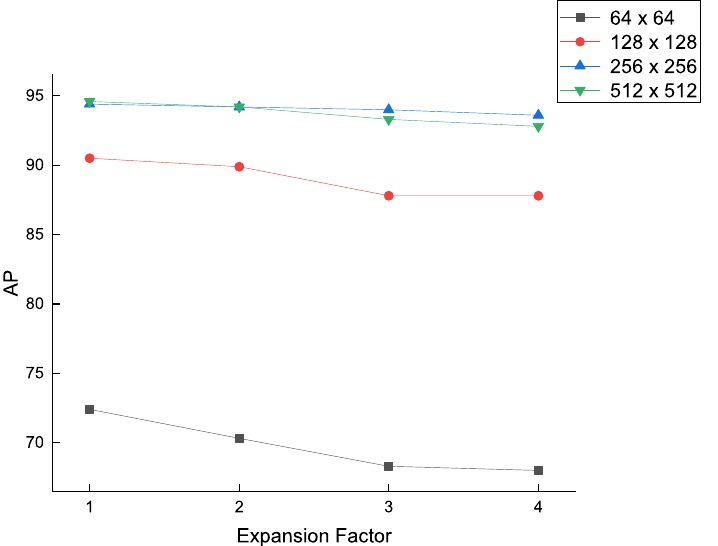
Figure 12. Analysis of the value of expansion factor µ , under various input resolution